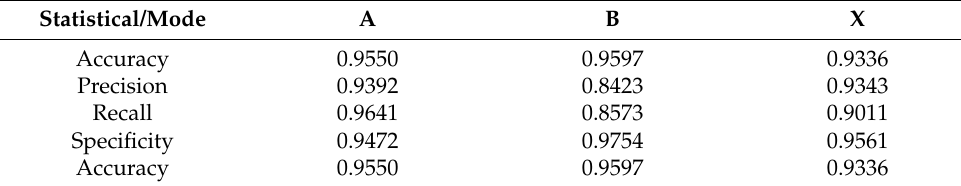
Table 3. Inference engine performance